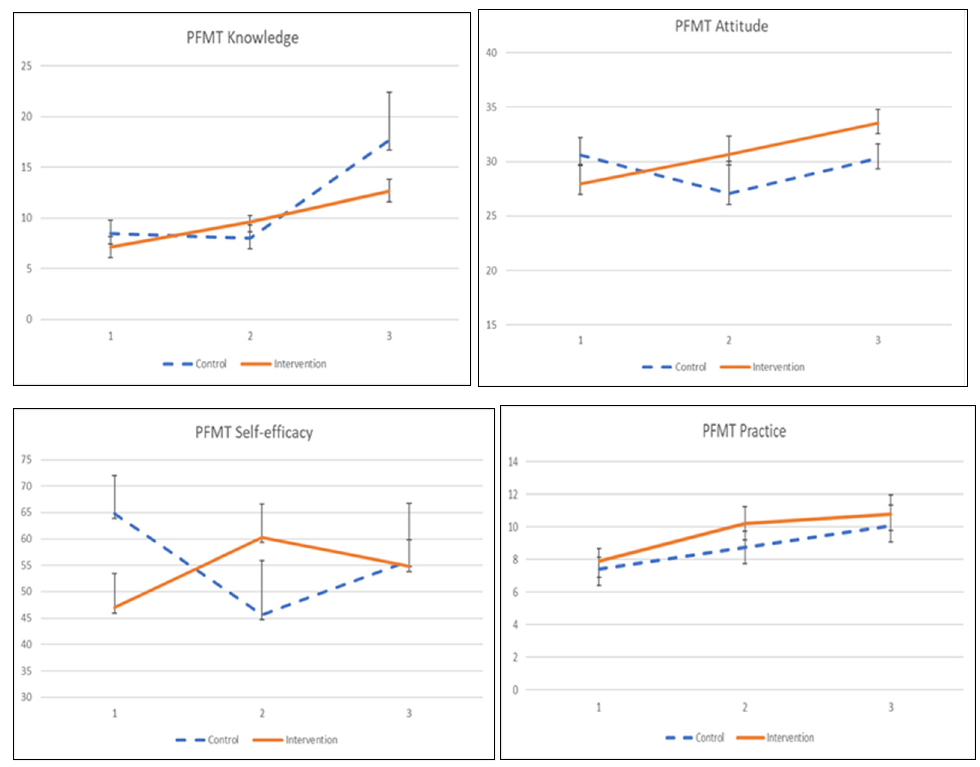
Figure 3. The mean values and standard errors for PFMT knowledge, attitude, practice, and self- efficacy of the two groups across this pilot RCT study.